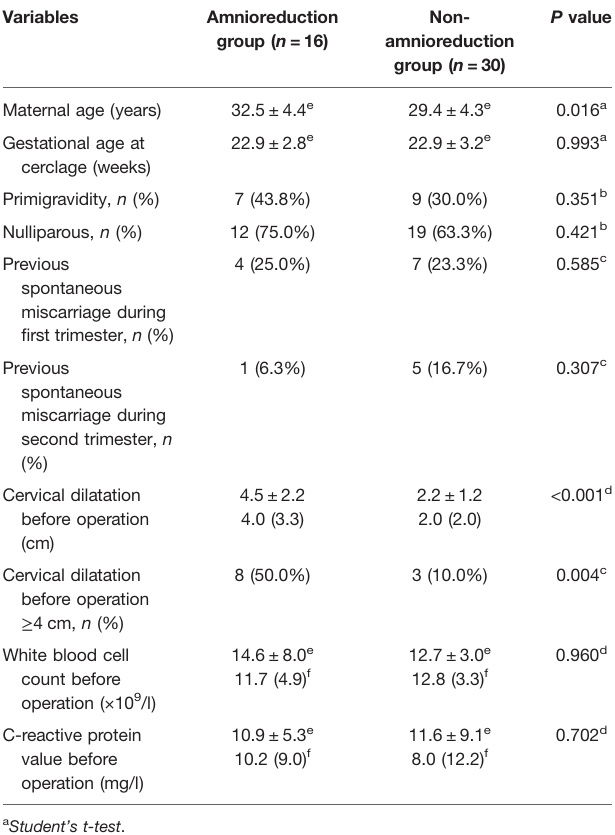
TABLE 1 | Baseline clinical characteristics of the included